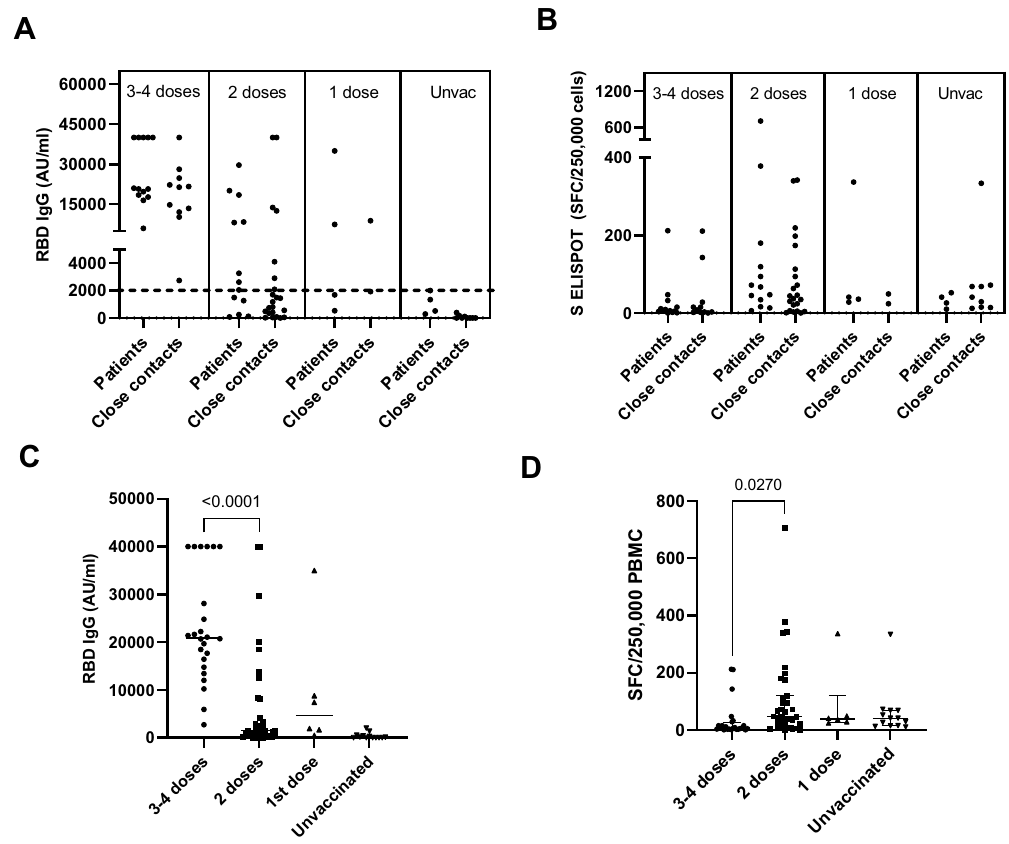
Figure 4. The antibody response ( A ) and T-cell response ( B ) against SARS-CoV-2 in patients (previous infection) and close contacts (noninfection) were stratified by the number of vaccine doses. There were no significant differences in the antibody response or T-cell response between patients and close contacts stratified by the number of vaccine doses. The antibody response against SARS-CoV-2 in patients and close contacts increased in a dose-dependent manner according to the number of vaccine doses. There was a significant difference in RBD IgG levels between those who received 2 doses vs. 3–4 doses (P < 0.0001, t = 5.682, df = 57) ( C